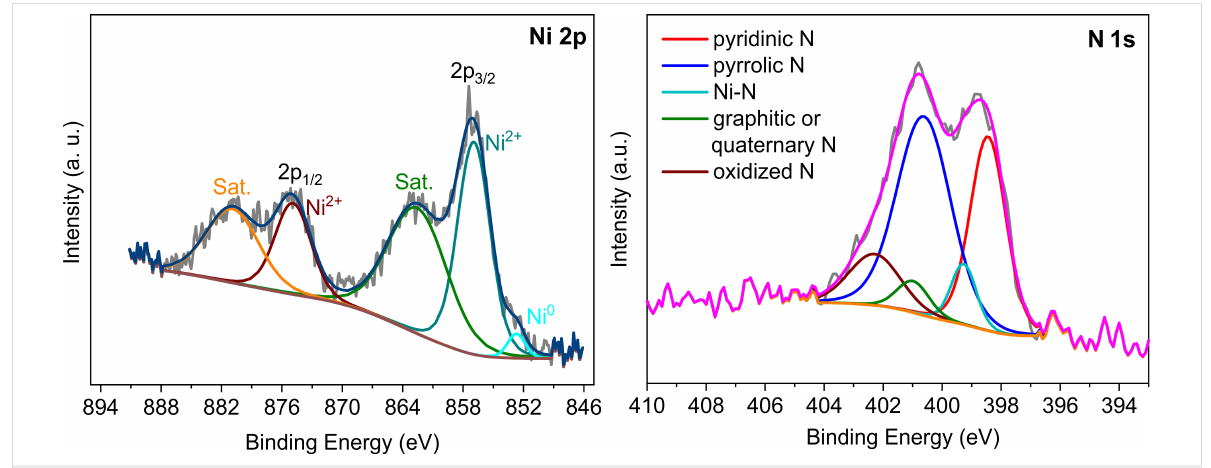
Figure 5: XPS measurements of Ni/CTF-1-600-22 with deconvoluted Ni 2p (left) (Sat. = satellite) and N 1s spectra (right).